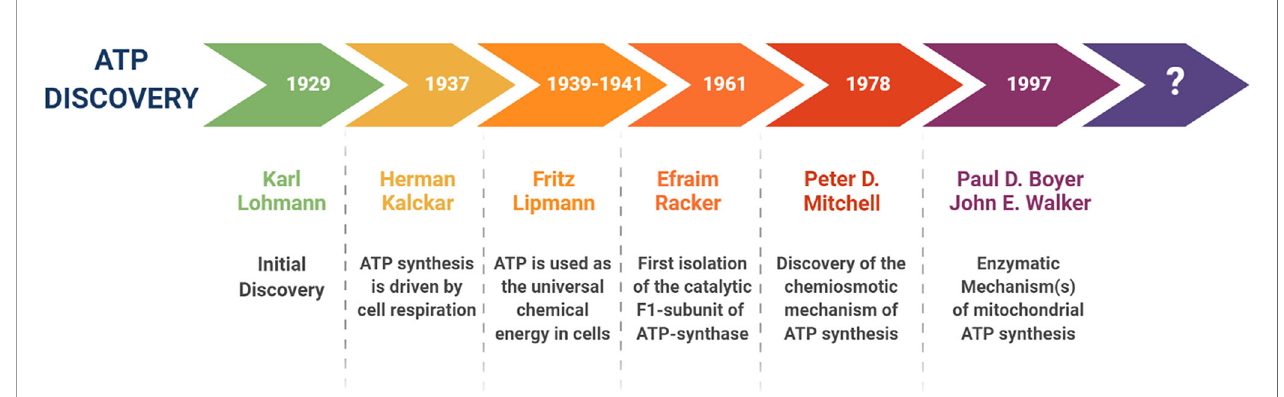
FIGURE 1 | A brief history of the discovery of ATP and its energetic function. This timeline highlights the key scientists and the events that contributed to our deeper understanding the structure, function and molecular machinery responsible for the synthesis of ATP, especially within